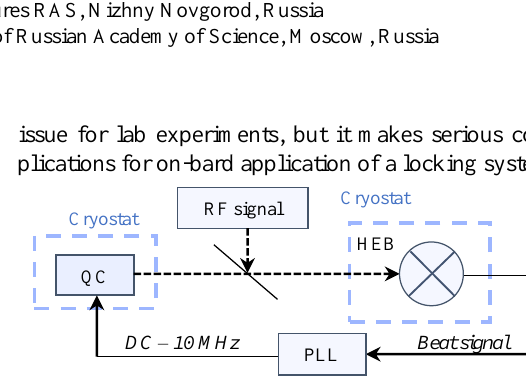
Fig. 1. Simplified block-diagram of QCL phase-locking described in papers [11], [12] and [14]. In all the cases the HEB mixer is used to provide a beat signal between the QLC and a reference signal. The RF signals in all the ap- proaches are generated in different way.